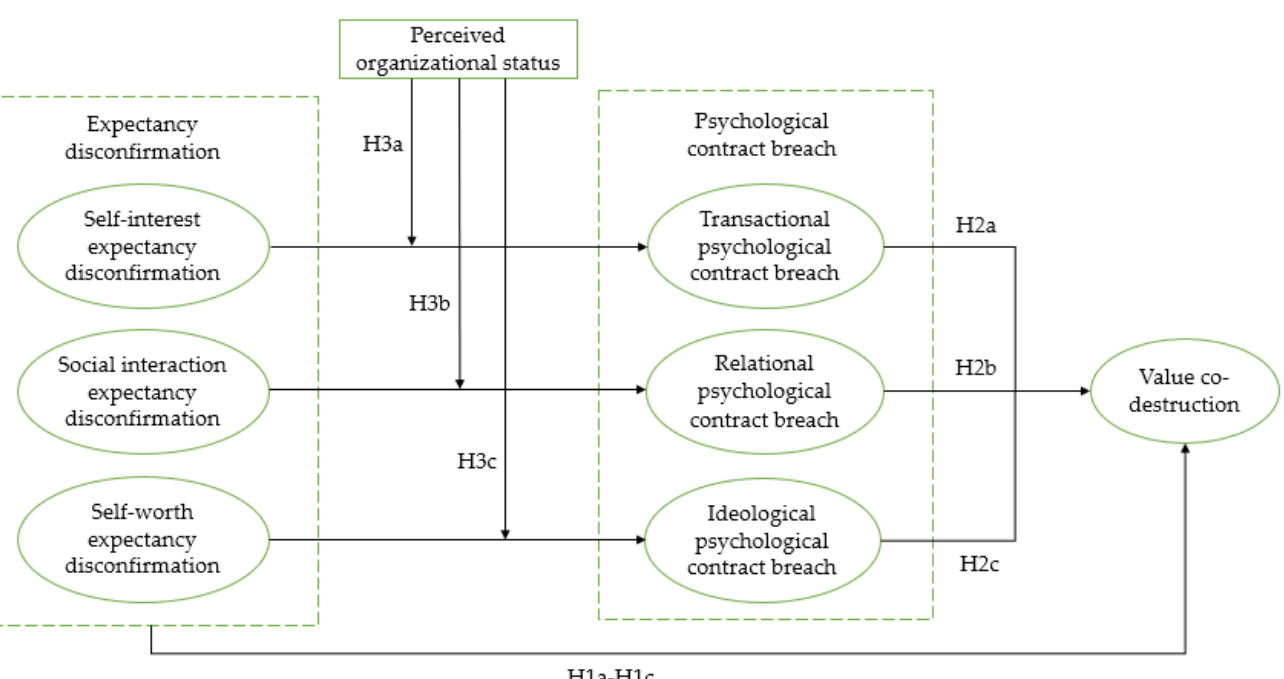
Figure 1. Research